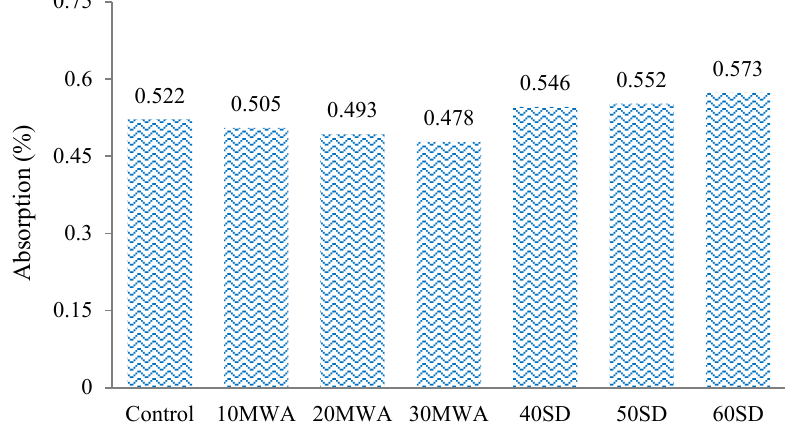
Figure 5. Absorption Percentage of specimens containing MWA and SD.